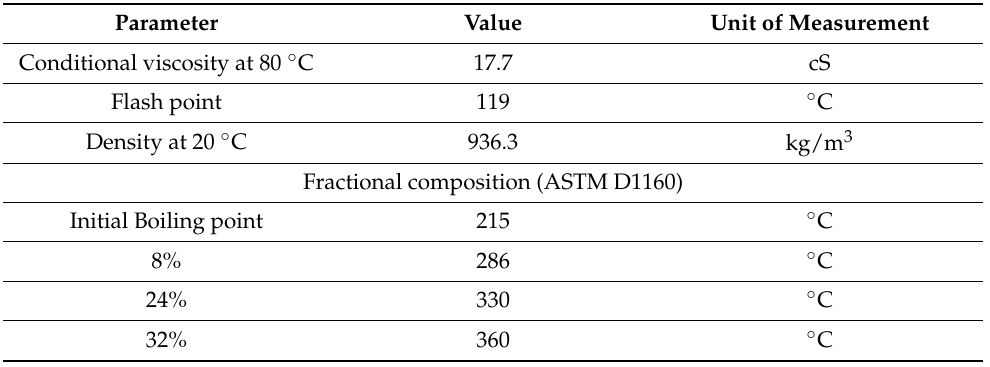
Table 5. Fuel oil parameters.